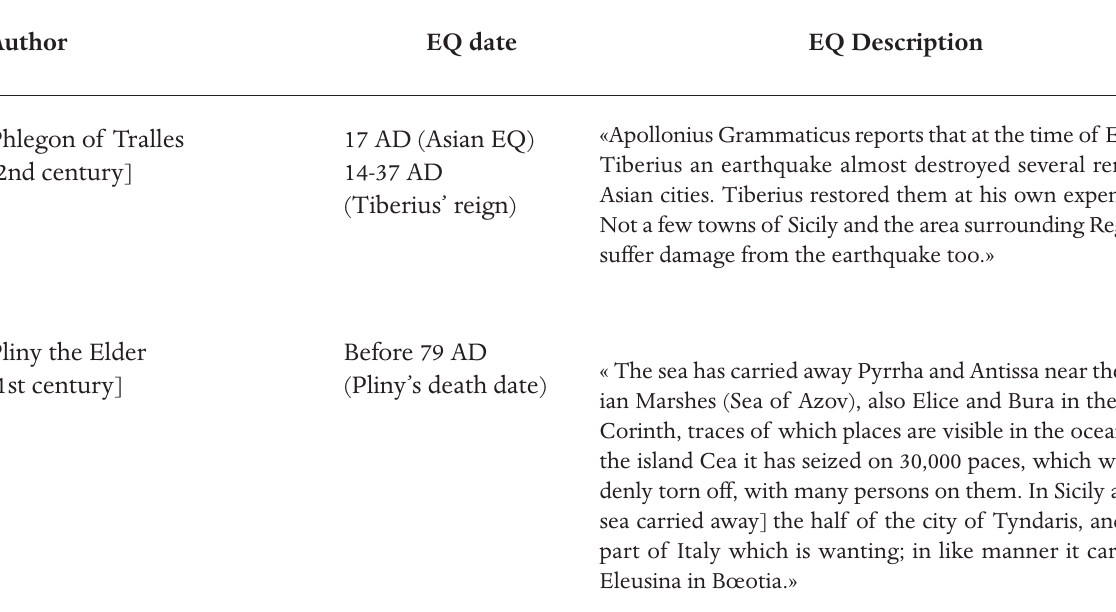
Table 2. Original information on an earthquake occurred in the first half of 1st century